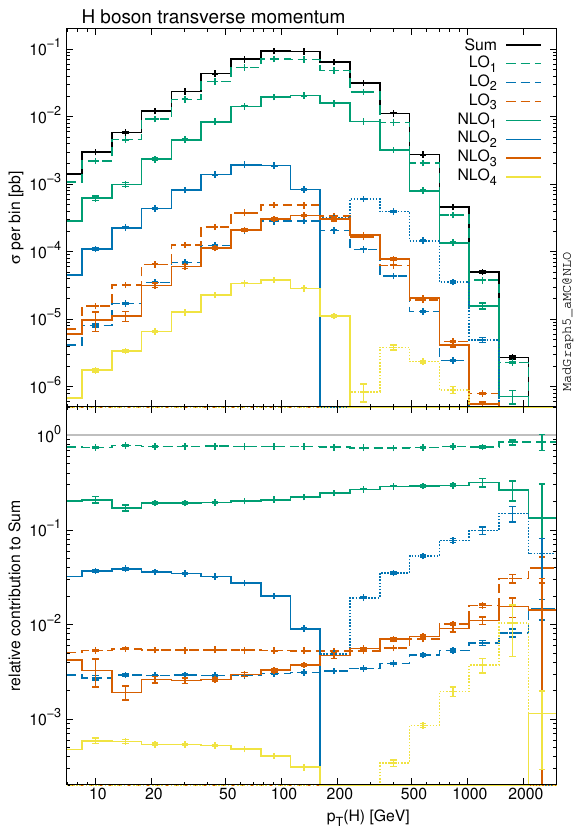
Figure 13. Transverse momentum of the Higgs boson in pp ! t (cid:22) tH